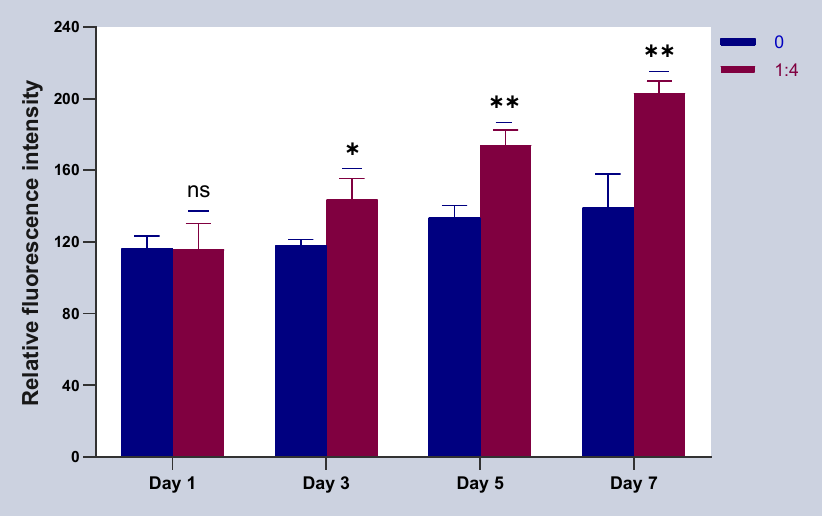
Figure 16. The statistical chart of fluorescence intensity of HSFs grown on the tissue engineering scaffolds. ns: p > 0.05, *: p < 0.05, **: p < 0.01.